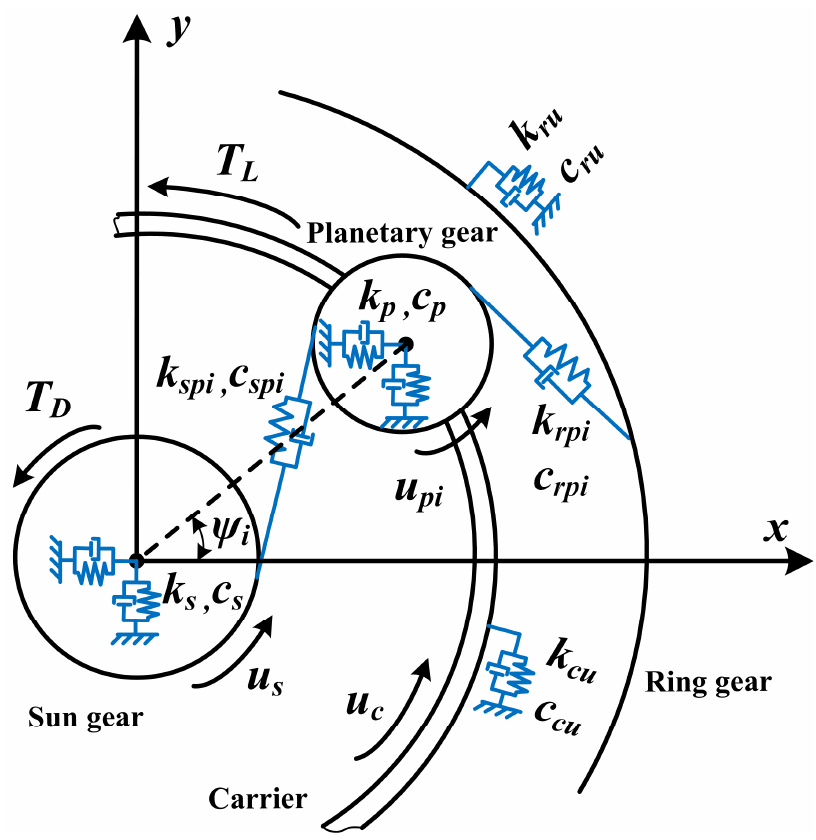
Figure 13. Dynamic model of the planetary gear system.